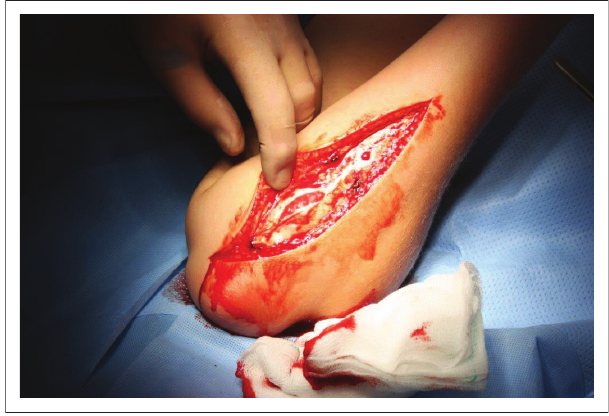
FIGURE 6: Completion